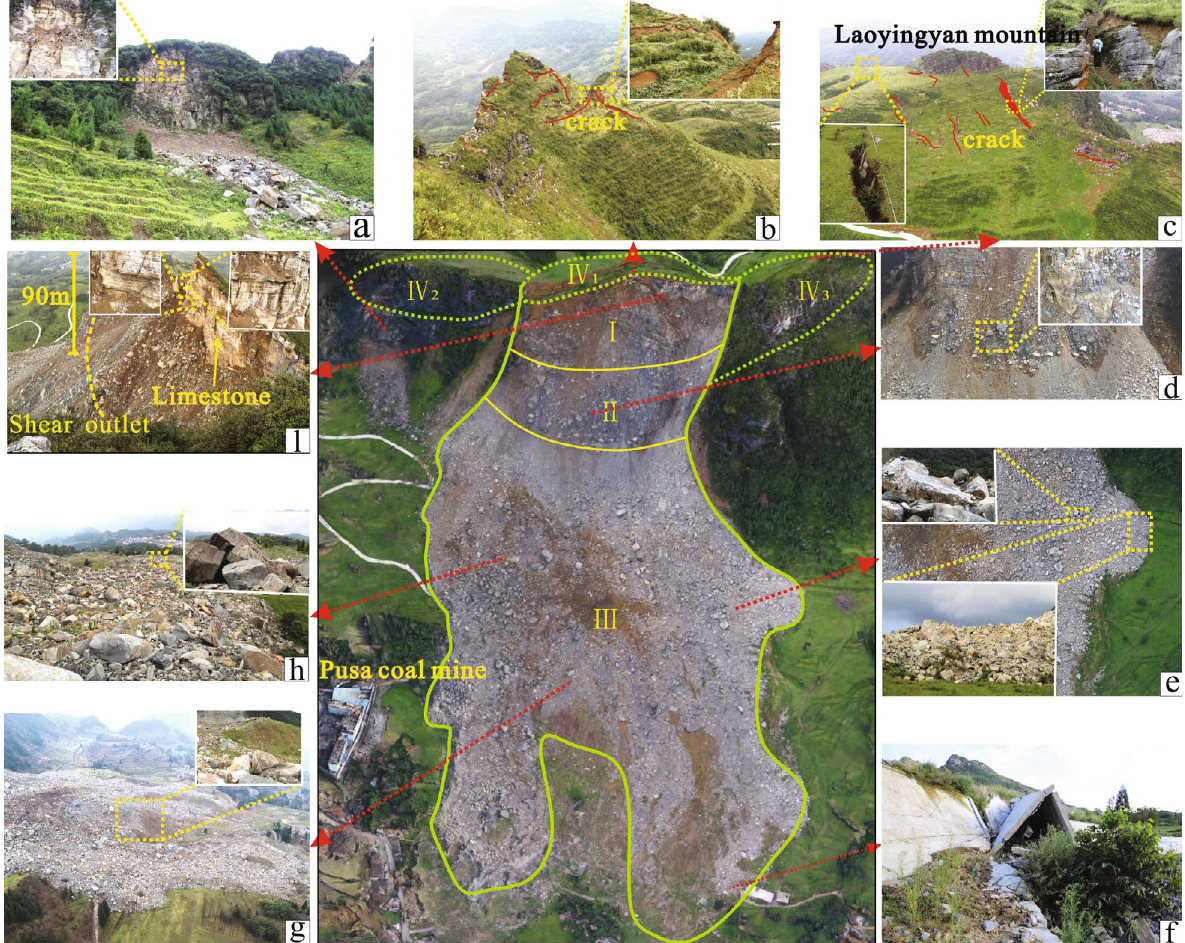
Figure 5: The full picture of the collapse. (I) Collapse source area. (II) Falling scraping area. (III) Flow stop accumulation area. (IV Perturbation area 1. (IV ) Perturbation area 2. (IV ) Perturbation area 2 3